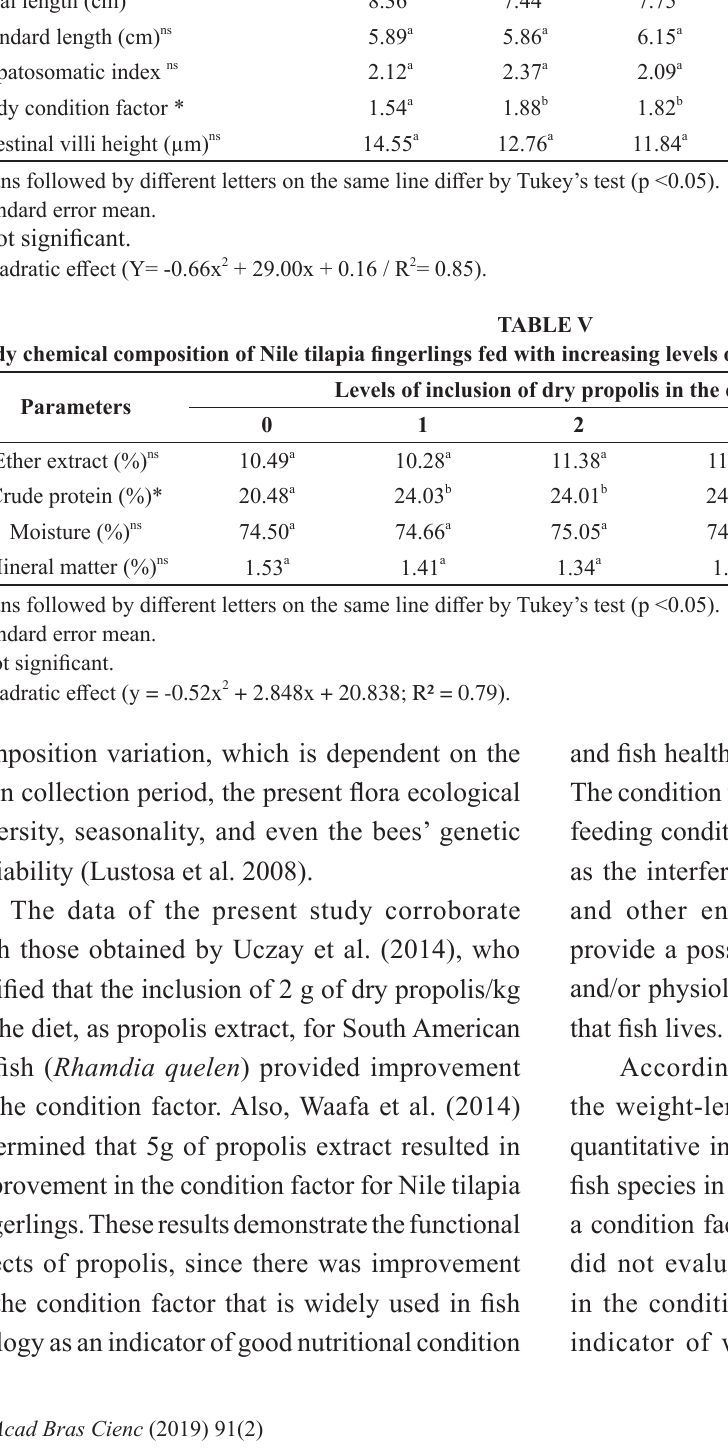
Hepatosomatic index ns